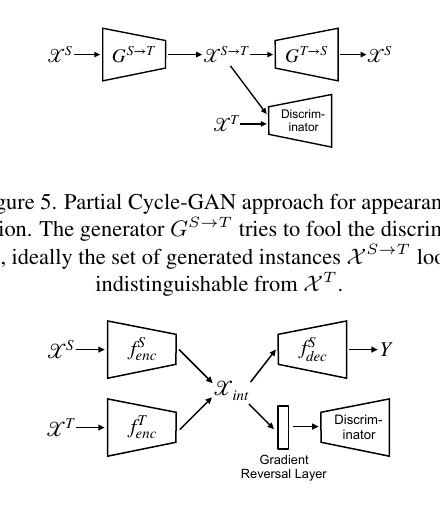
Figure 6. DANN approach for feature level domain adaptation which is capable of transforming data drawn from one distribu- tion (noise) into data drawn from another distribution